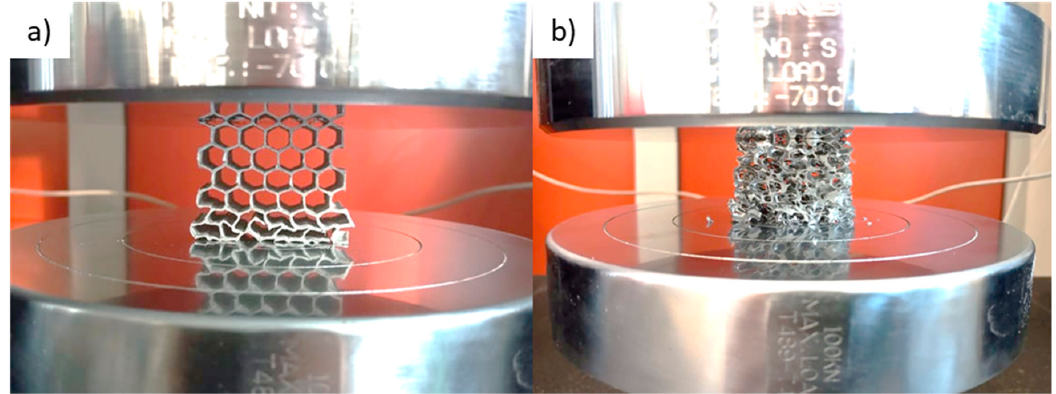
Figure 6. Samples during compressive tests: ( a ) honeycomb, ( b ) foam (10 PPI).